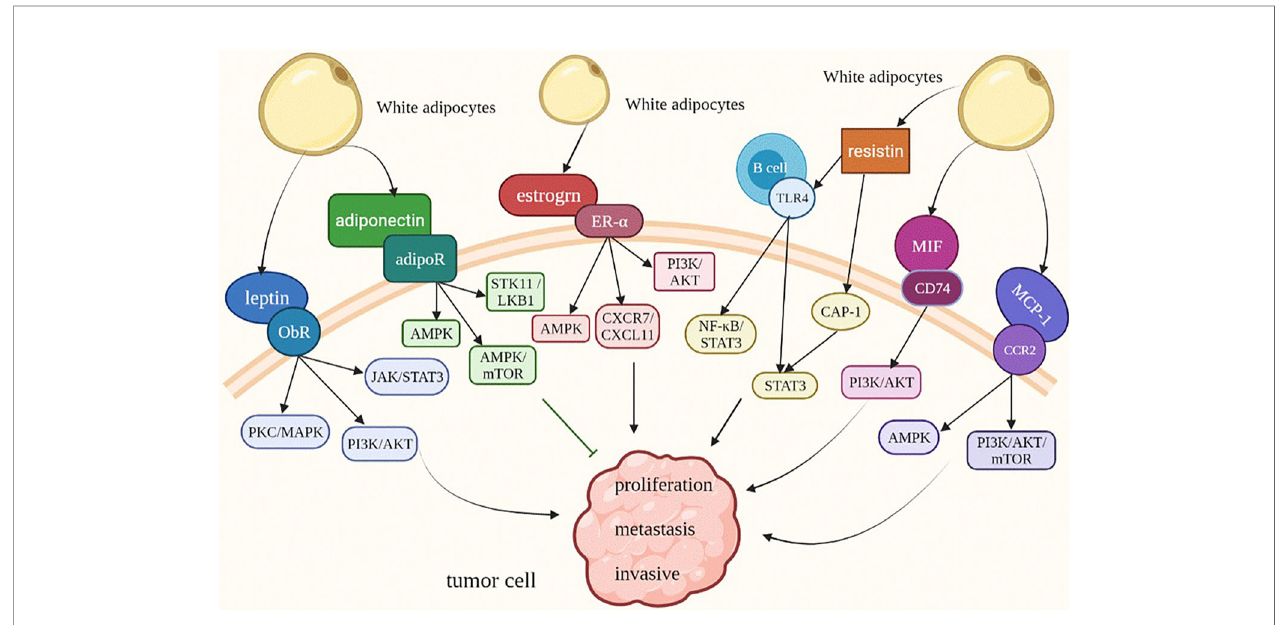
FIGURE 2 | Adipokines modify the behavior of obesity-related tumor cells. ObR, leptin receptor; JAK/STAT3, Janus kinase/signal transducer and activator of transcription 3; MAPK/ERK, mitogen-activated protein kinase/extractor signal regulated kinase; PI3K/AKT, phosphoinositide-3 kinase/protein kinase B; AMPK, AMP-activated protein kinase; STK11/LKB1, Serine/threonine kinase 11/Liver Kinase B1; TLR4, Toll-like receptor 4; CAP1, adenylate cyclase-related protein